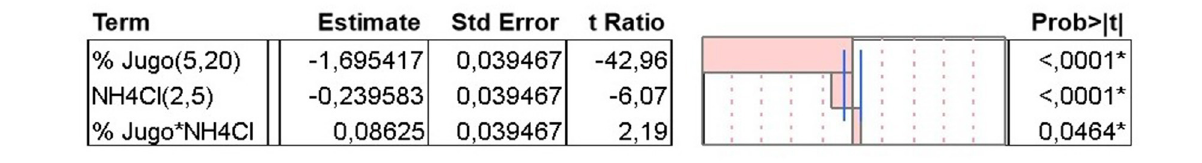
FIGURE 1 | Sorted parameter estimates for the response surface analysis: effect of JBP and NH 4 Cl concentrations in culture medium and their interaction in C. necator cell density. *marks statistically significant factors for p < 0.05.